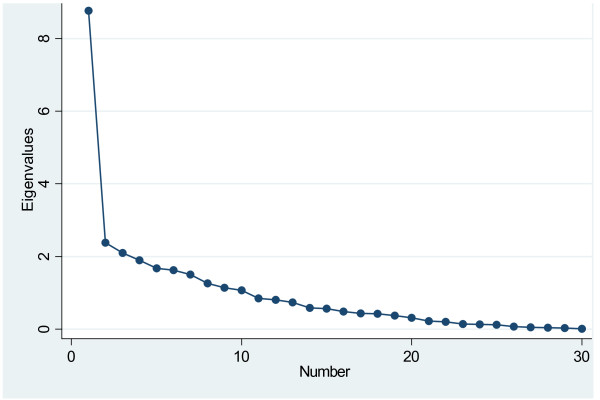
Screeplot of 30-item adapted Arabic BD-QoL.